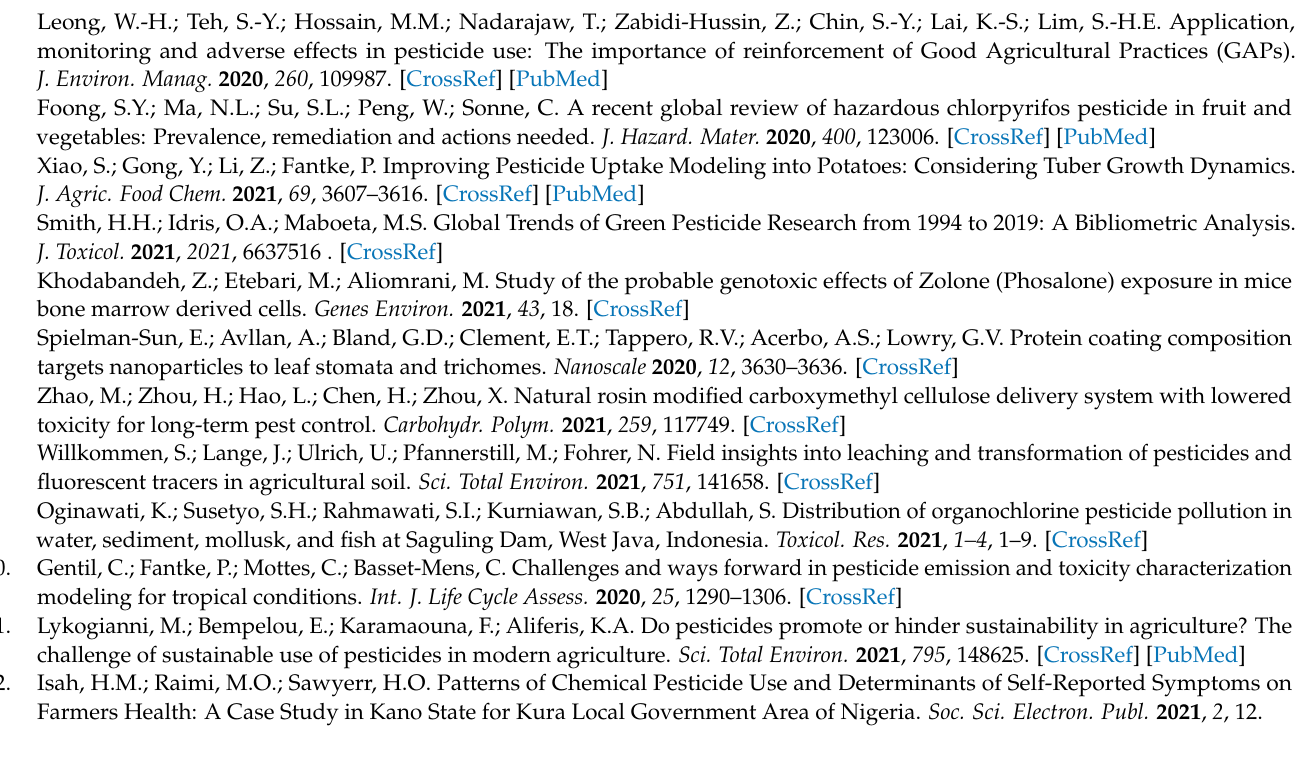
bars represent the SE ( N = 3). Different lower case letters indicate significant differences between treatments ( p < 0.05); Figure S2: HPLC standard curves of Pyr; Figure S3: Loading capacity of Pyr on GO at different concentration ratio; Figure S4: Images of GO-Pyr under storage of 0 ◦ C and 54 ◦ C; Figure S5: Images of GO-Pyr in 2 years of